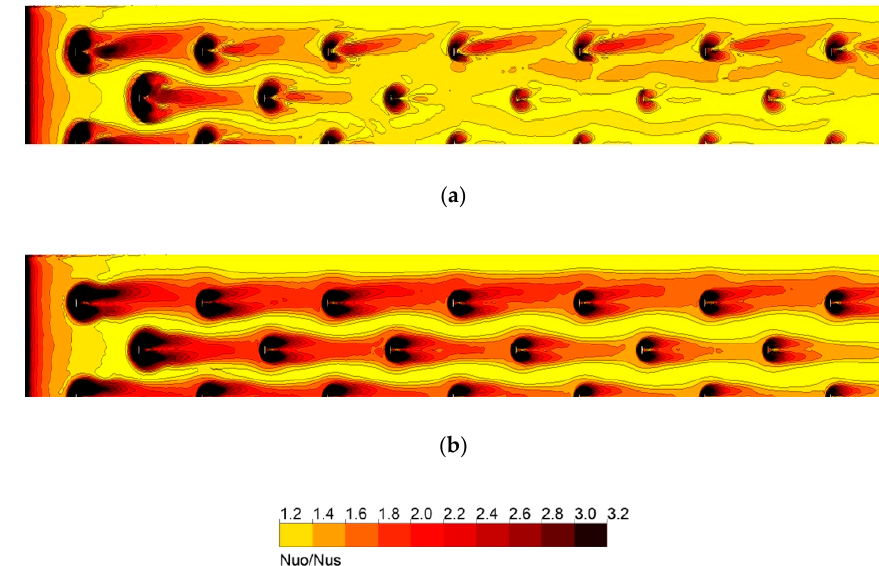
Figure 9. Nusselt number distributions on the heated surface for different h/H. ( a ) h/H = 0.3, ( b ) h/H = 0.5.